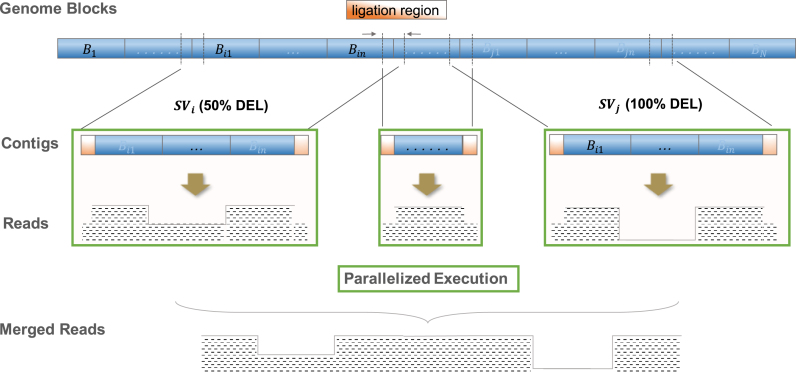
The core parallelized simulation algorithm of SVEngine. Here are two neighboring events \documentclass[12pt]{minimal}
\usepackage{amsmath}
\usepackage{wasysym}
\usepackage{amsfonts}
\usepackage{amssymb}
\usepackage{amsbsy}
\usepackage{upgreek}
\usepackage{mathrsfs}
\setlength{\oddsidemargin}{-69pt}
\begin{document}
}{}$S{V_i}$\end{document} and \documentclass[12pt]{minimal}
\usepackage{amsmath}
\usepackage{wasysym}
\usepackage{amsfonts}
\usepackage{amssymb}
\usepackage{amsbsy}
\usepackage{upgreek}
\usepackage{mathrsfs}
\setlength{\oddsidemargin}{-69pt}
\begin{document}
}{}$S{V_j}$\end{document}: a 50% deletion and a 100% deletion to be spiked in. The first deletion event spans blocks \documentclass[12pt]{minimal}
\usepackage{amsmath}
\usepackage{wasysym}
\usepackage{amsfonts}
\usepackage{amssymb}
\usepackage{amsbsy}
\usepackage{upgreek}
\usepackage{mathrsfs}
\setlength{\oddsidemargin}{-69pt}
\begin{document}
}{}${B_{{i_1}}}$\end{document},\documentclass[12pt]{minimal}
\usepackage{amsmath}
\usepackage{wasysym}
\usepackage{amsfonts}
\usepackage{amssymb}
\usepackage{amsbsy}
\usepackage{upgreek}
\usepackage{mathrsfs}
\setlength{\oddsidemargin}{-69pt}
\begin{document}
}{}${\rm{\,}}{B_{{i_1} + 1}}$\end{document}, …,\documentclass[12pt]{minimal}
\usepackage{amsmath}
\usepackage{wasysym}
\usepackage{amsfonts}
\usepackage{amssymb}
\usepackage{amsbsy}
\usepackage{upgreek}
\usepackage{mathrsfs}
\setlength{\oddsidemargin}{-69pt}
\begin{document}
}{}${\rm{\,}}{B_{{i_n}}}$\end{document}, and the second deletion event spans genome blocks \documentclass[12pt]{minimal}
\usepackage{amsmath}
\usepackage{wasysym}
\usepackage{amsfonts}
\usepackage{amssymb}
\usepackage{amsbsy}
\usepackage{upgreek}
\usepackage{mathrsfs}
\setlength{\oddsidemargin}{-69pt}
\begin{document}
}{}${B_{{j_1}}}$\end{document},\documentclass[12pt]{minimal}
\usepackage{amsmath}
\usepackage{wasysym}
\usepackage{amsfonts}
\usepackage{amssymb}
\usepackage{amsbsy}
\usepackage{upgreek}
\usepackage{mathrsfs}
\setlength{\oddsidemargin}{-69pt}
\begin{document}
}{}${\rm{\,}}{B_{{j_1} + 1}}$\end{document}, …,\documentclass[12pt]{minimal}
\usepackage{amsmath}
\usepackage{wasysym}
\usepackage{amsfonts}
\usepackage{amssymb}
\usepackage{amsbsy}
\usepackage{upgreek}
\usepackage{mathrsfs}
\setlength{\oddsidemargin}{-69pt}
\begin{document}
}{}${\rm{\,}}{B_{{j_n}}}$\end{document}. The genome blocks are shaded in blue, and the ligation regions are shaded in orange. The resulting read pairs are represented by their coverage in black dash patterns. The parallel execution tasks are boxed in green.